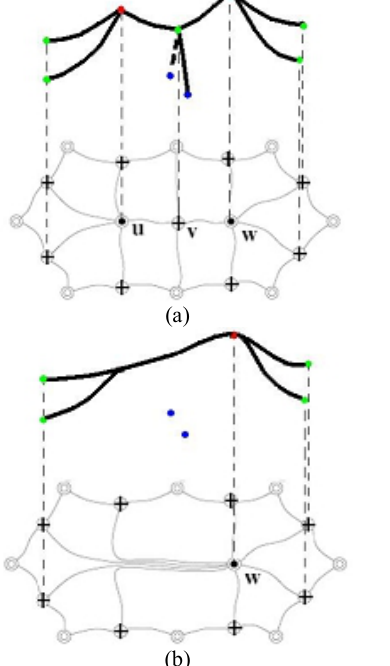
Figure 5. The basic operation of topological simplification: (a) before simplification, (b) after